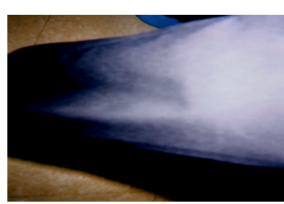
Figure 14. Partner’s